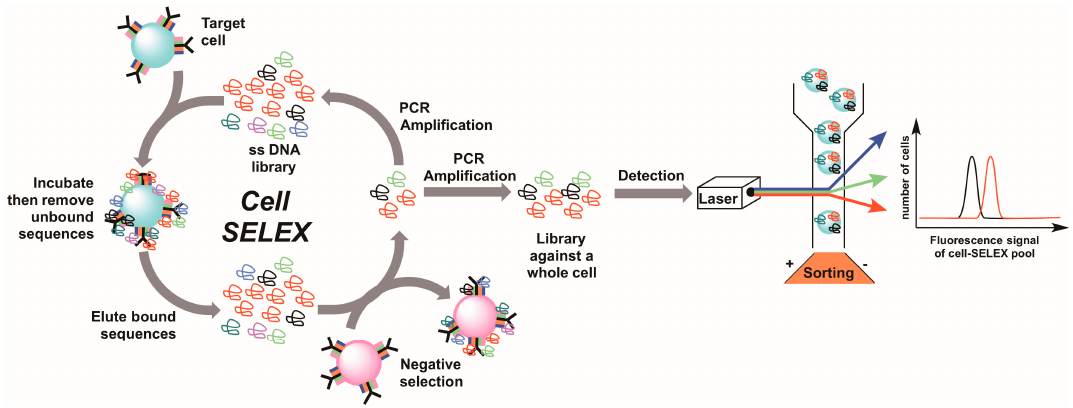
Figure 2. Outline of cell-SELEX with negative screening to increase selection pressure. The ability to detect enrichment of the SELEX pool using flow cytometry without altering the conditions used in the selection step enhanced the relevance of aptamers as diagnostic agents for hematopoietic diseases. Next, aptamers selected using live cell–SELEX also showed specific binding when leukemia cells were mixed with cells obtained from human peripheral blood mononuclear cell (PBMC) samples. For